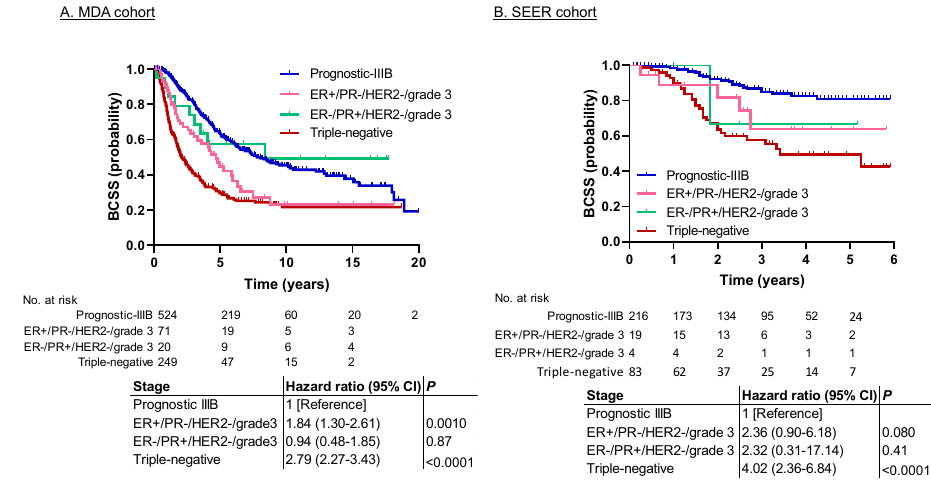
Figure 3. Survival analysis of prognostic stage IIIB and subgroups of prognostic stage IIIC for BCSS in the ( A ) MDA cohort and the ( B ) SEER cohort. The BCSS for ER +/ PR − / HER2 − / grade 3 and ER − / PR +/ HER2 − / grade 3 was better than that for triple-negative IBC and worse than that for prognostic stage IIIB in both cohorts. Abbreviations: BCSS, breast cancer-specific survival; ER, estrogen receptor; HER2, human epidermal growth factor receptor 2; PR, progesterone receptor.